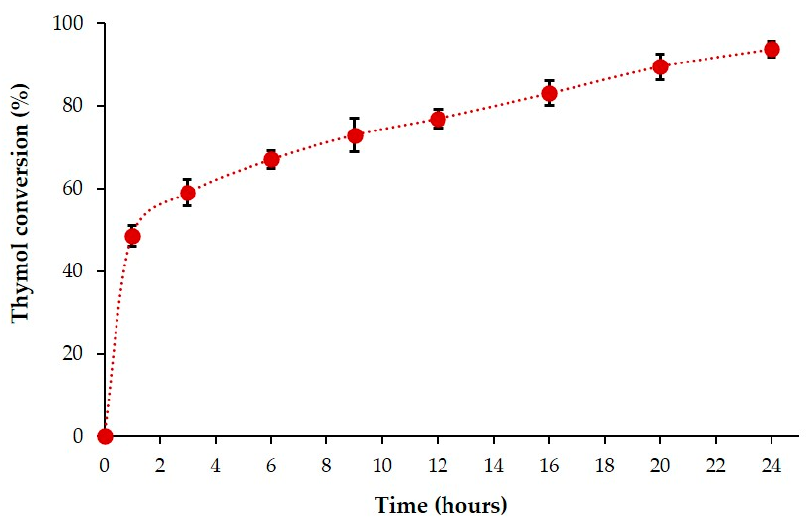
Figure 7. Variation of thymol conversion as a function of reaction time. Reaction conditions: 2 mmol of octanoic acid, 0.5 mmol of thymol, 200 µL of CALB solution, 50 °C, and magnetic stirring at 200 rpm.